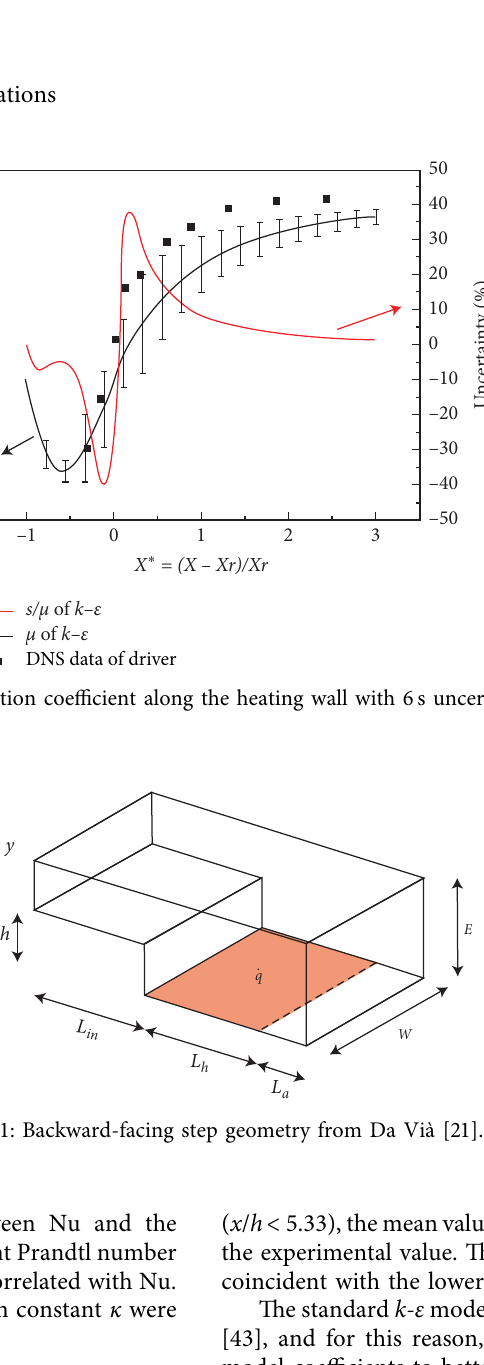
( X ∗ � 0). At four times of Xr , the uncertainty gradually decreased to zero: